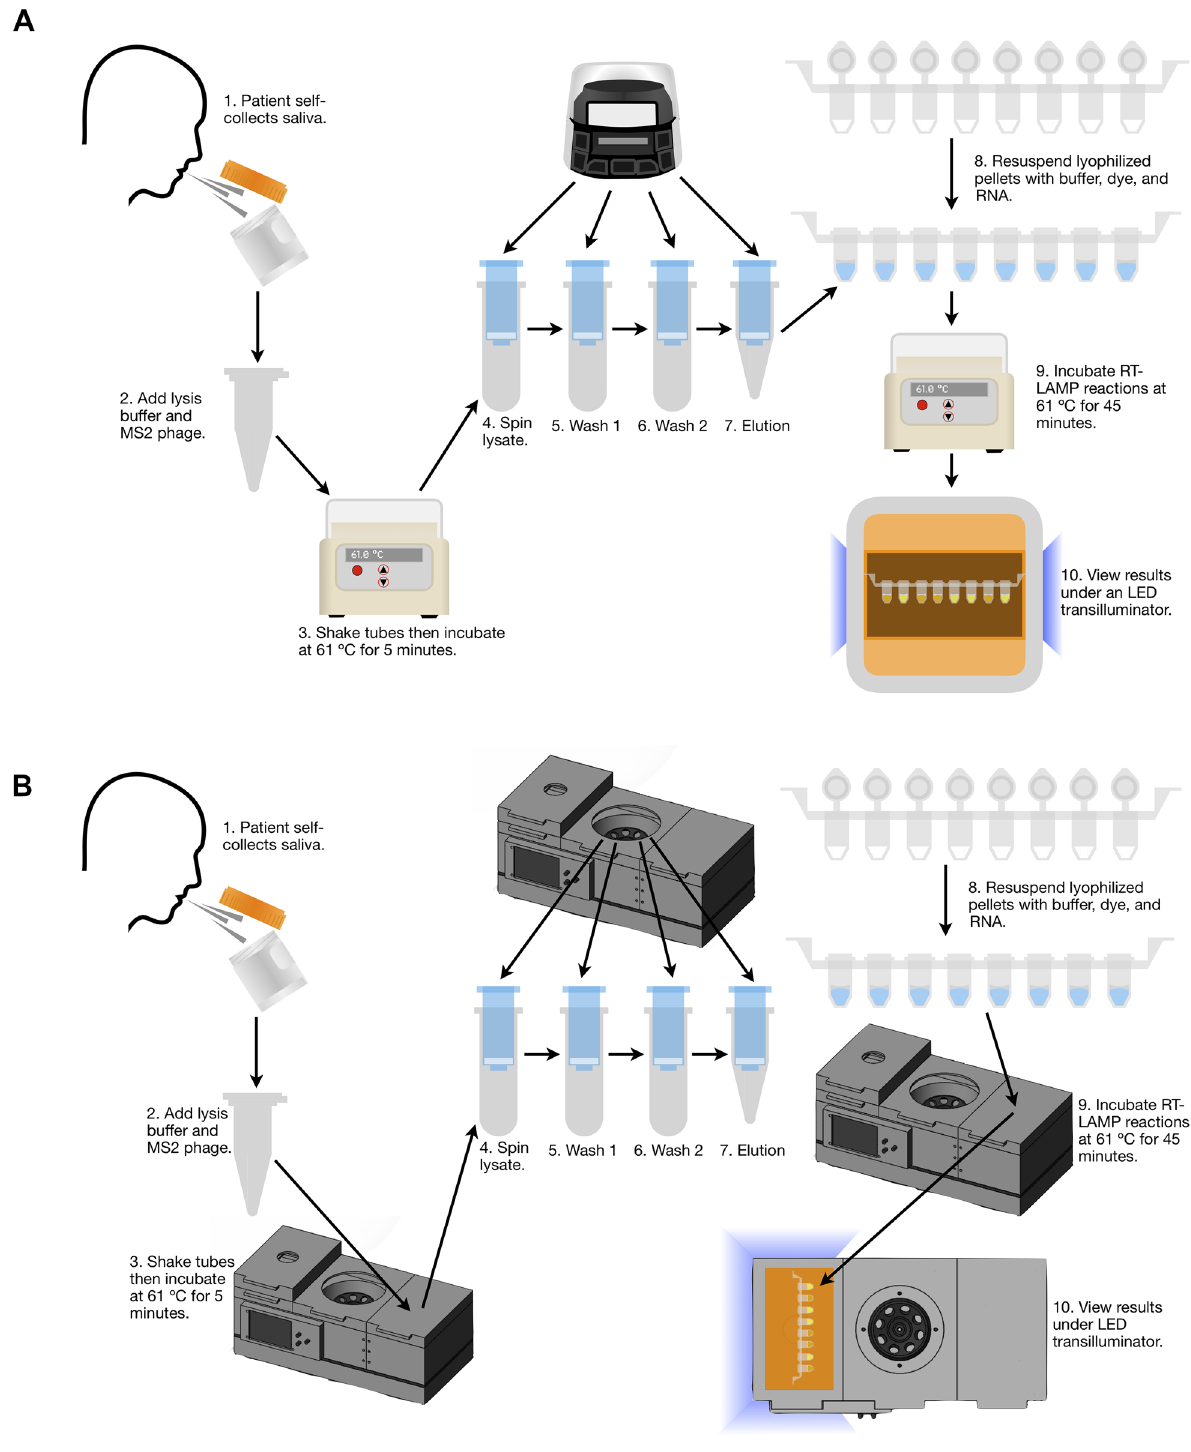
Figure 3. Saliva-Dry LAMP workflow diagram and equipment requirements. The workflow for conducting Saliva-Dry LAMP on ( A ) commercially-available instruments and ( B ) the